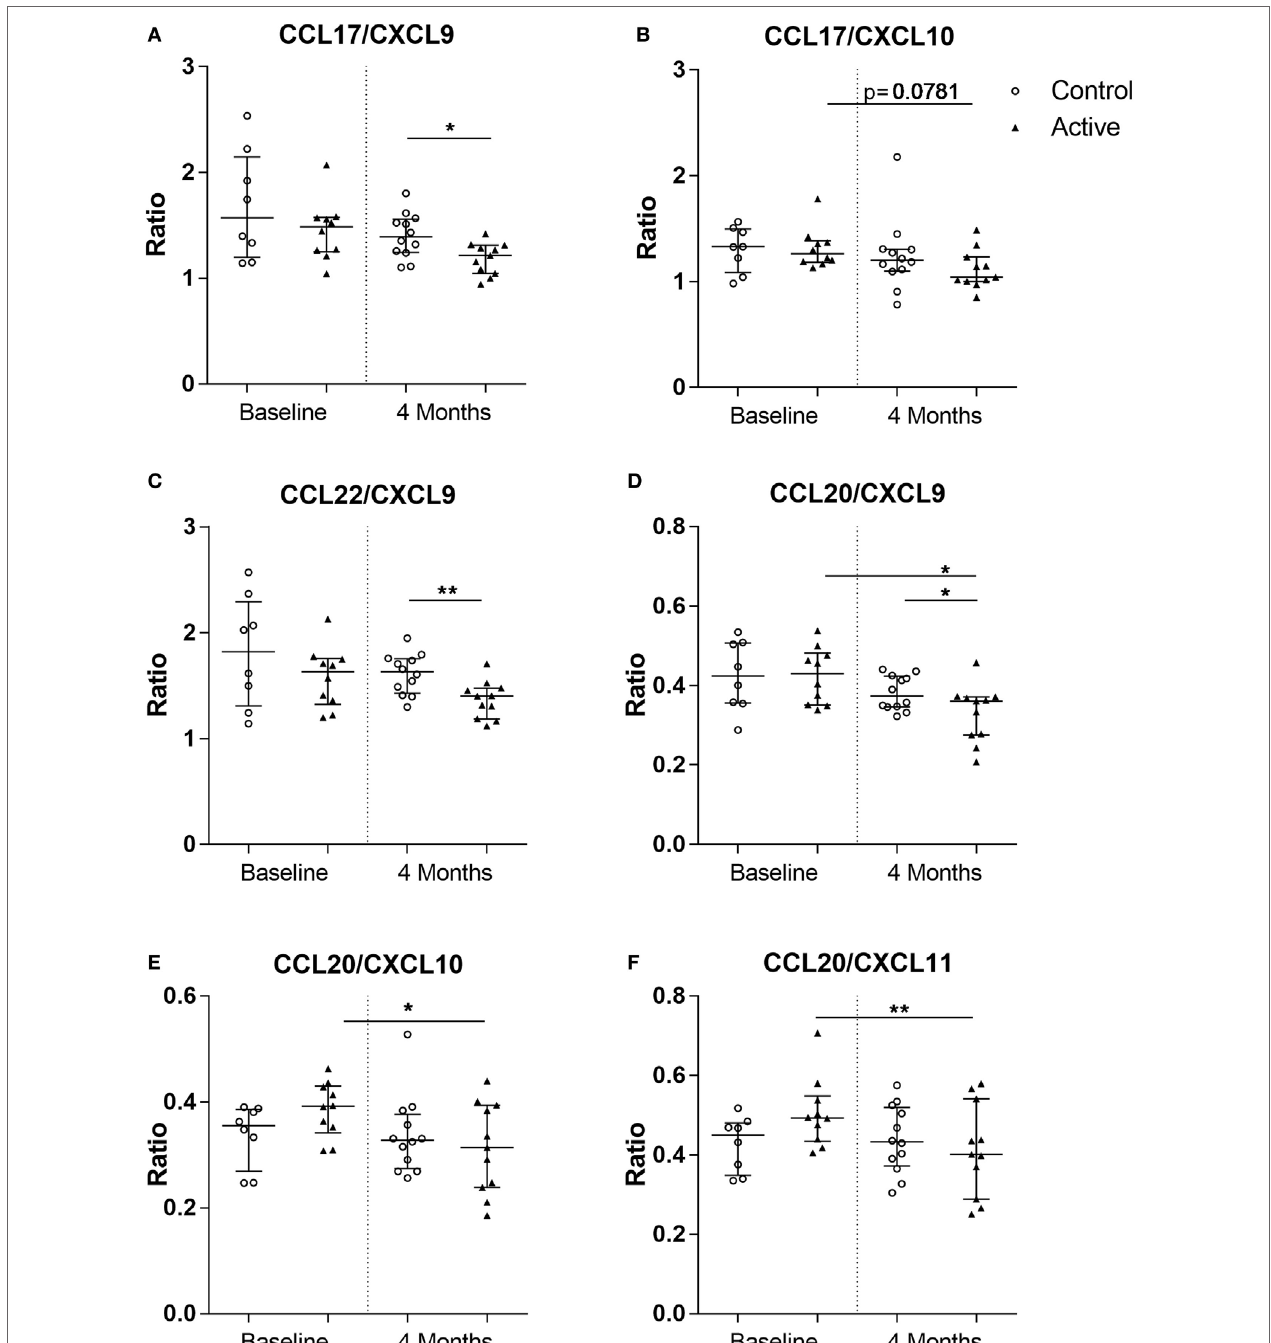
FigUre 4 | Chemokine ratios calculated in the control (open dots, n = 20) and active (closed triangles, n = 21) groups before and after dietary intervention. CC chemokine ligand (CCL) 17/CXC chemokine ligand (CXCL) 9 (a) , CCL17/CXCL10 (B) , CCL22/CXCL9 (c) , CCL20/CXCL9 (D) , CCL20/CXCL10 (e) , and CCL20/ CXCL11 (F) . Line represents median ± interquartile range. Significant differences within the groups are depicted with asterisks (non-paired W-test, * p < 0.05, ** p < 0.01) and between groups (using Mann–Whitney U -test, * p < 0.05, ** p <